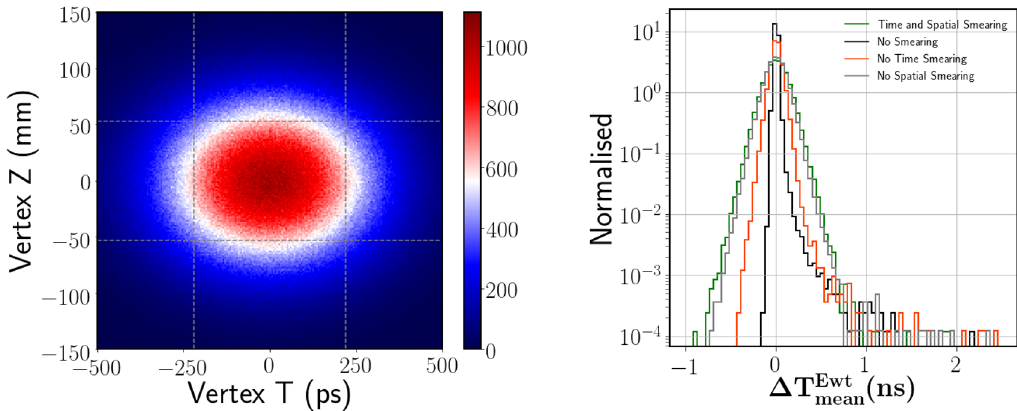
Figure 5 . Left: distribution of vertices on the beamline in the temporal and longitudinal direction at HL-LHC for 1 million soft QCD events with an average of 140 vertices in each event. Right: distribution of energy-weighted mean timing ( ∆ T Ewt ) of QCD prompt jets from dijet process in mean the p gen ∈ { 30 , 50 } GeV bin without and with both the time and spatial smearing, along with their T individual